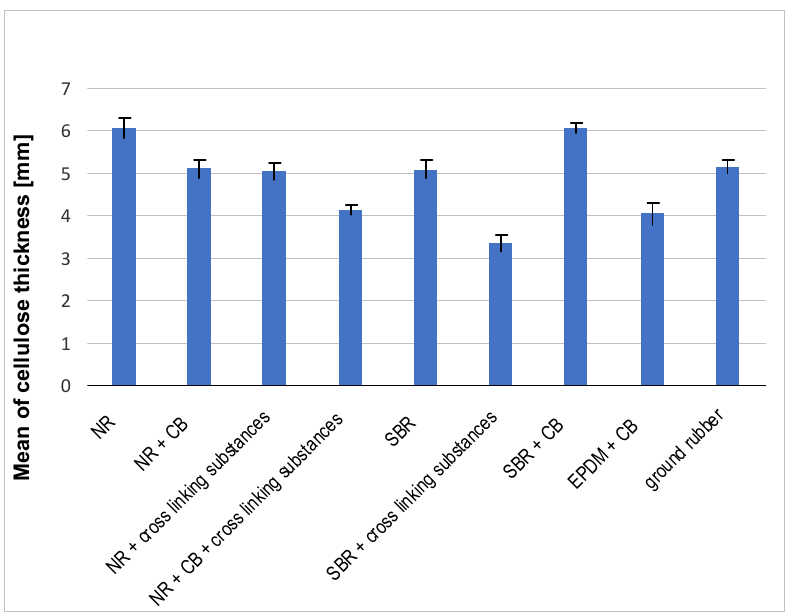
Figure 2. The mean thickness of bacterial cellulose after 14 days of culturing with an addition of different carbon sources.